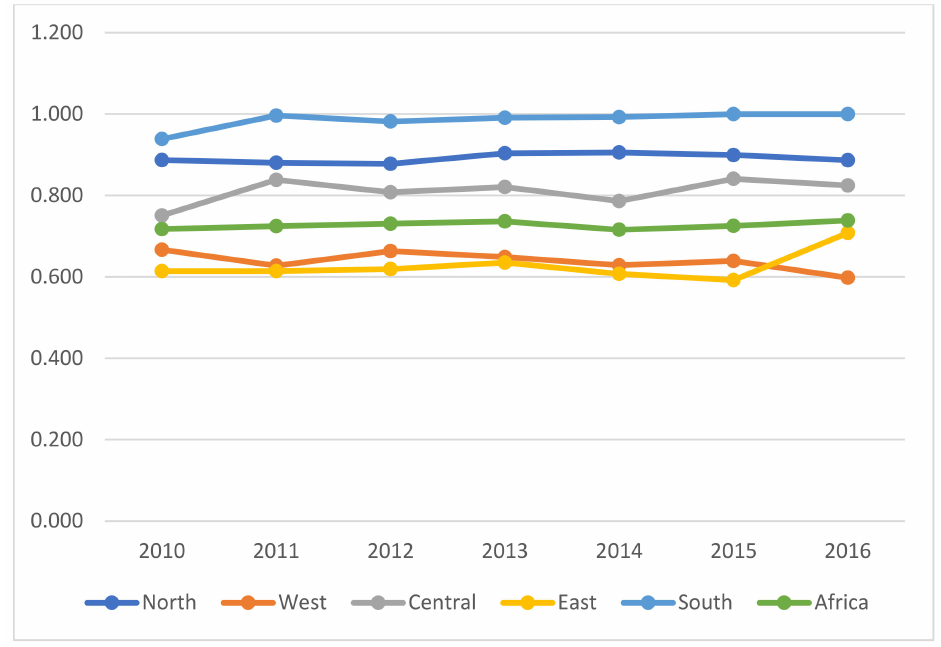
Figure 3. Annual mean trends of GDSTFEE across the five regions in Africa (2010–2016).